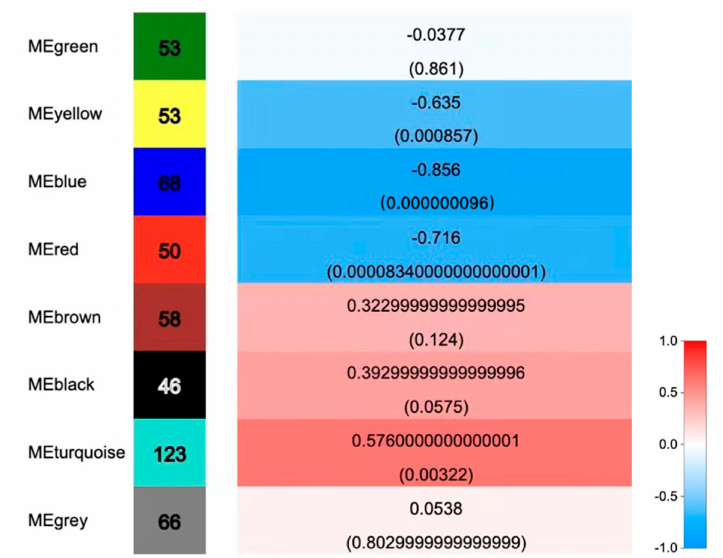
Figure 6. Correlations between WGCNA and crude fat mass